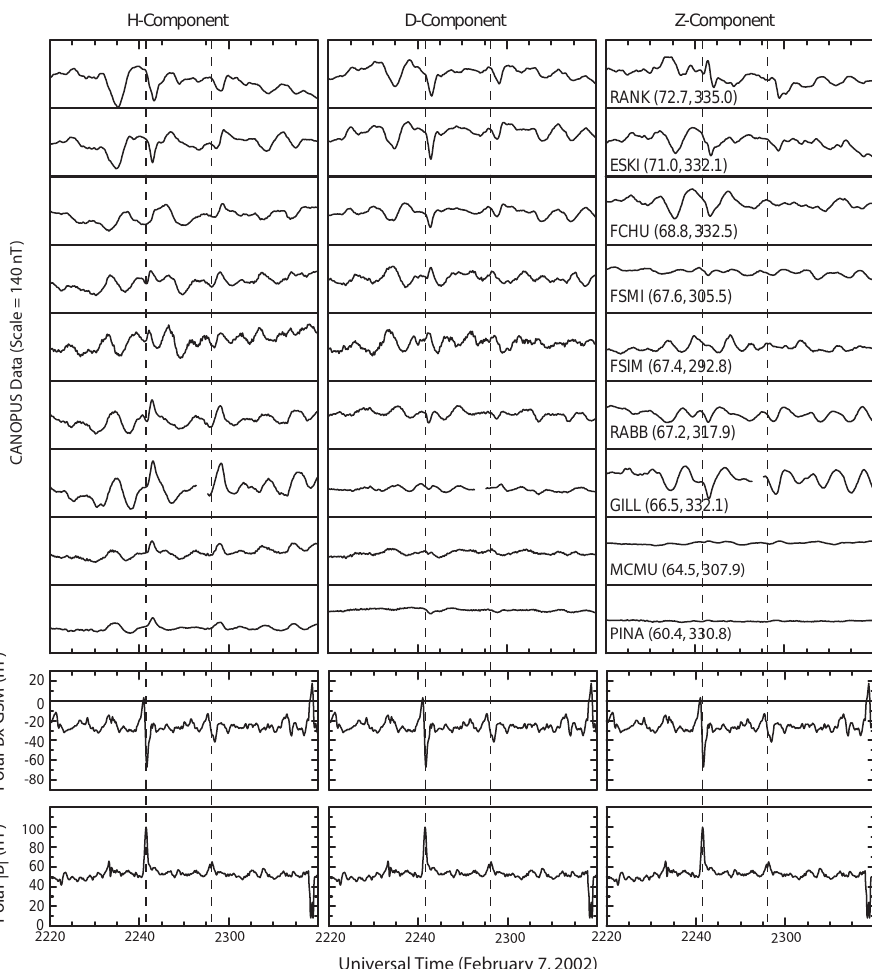
Fig. 14. Expanded view of the CANOPUS magnetic field data, as well as the simultaneous Polar B x -component in GSM coordinates and the field strength showing the ground signature of flux transfer events.